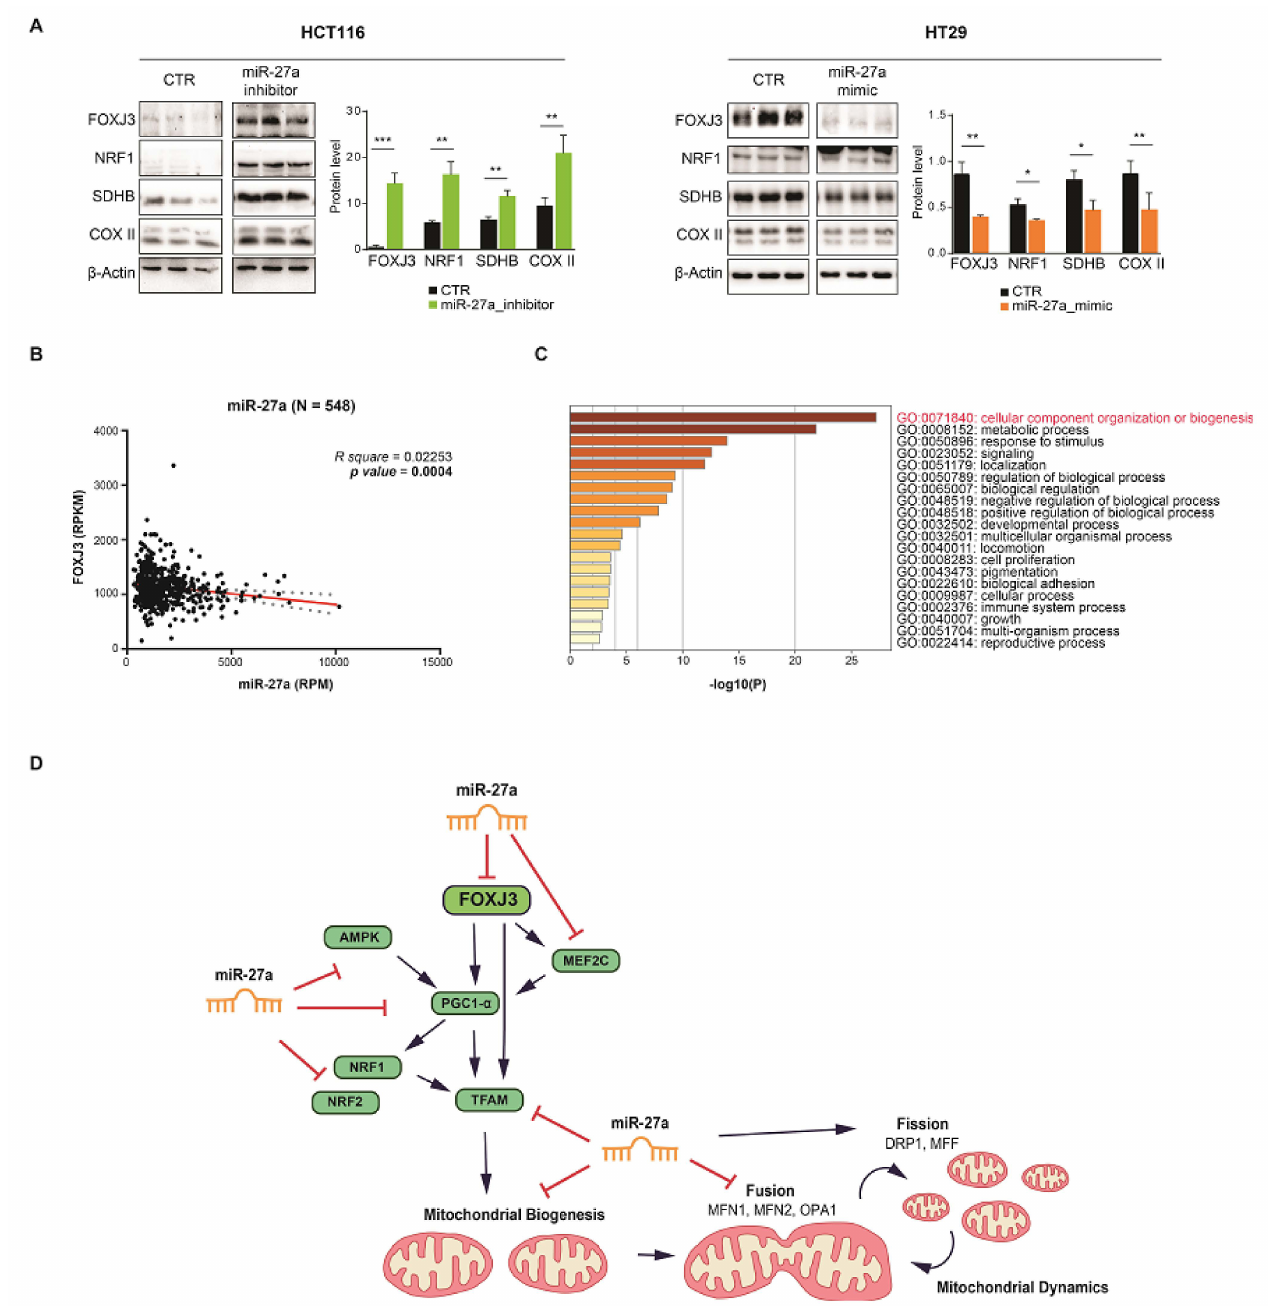
Figure 6. FOXJ3 is a target of miR-27a in a mouse xenograft model in vivo and in a CRC dataset. ( A ) Representative immunoblot for FOXJ3, NRF1, SDHB, and COX II on extracts from xenografts of HCT116 and HT29 cells in immune- compromised mice that were intratumorally injected with an miR-27a inhibitor or mimic, respectively, or scrambled controls. The data shown are the mean of experiments ± SEM performed on extracts from N = 3 mice per each type, expressed as protein levels with respect to β -actin as a loading control. Statistical significance was considered when * p ≤ 0.05, ** p ≤ 0.01, or *** p ≤ 0.001 ( t -test). ( B ) Correlation of FOXJ3 with miR-27a expression in TCGA-COADREAD patients; N = 548 and p = 0.0004. ( C ) The bar graph illustrates the top Gene Ontology biological processes, identified via Metascape, using a discrete color scale to represent statistical significance (a deeper color indicates a smaller p -value). ( D ) This drawing depicts the key factors involved in mitochondrial biogenesis and dynamics, their reciprocal modulation, and their overall regulation by miR-27a. File S1: Original Western